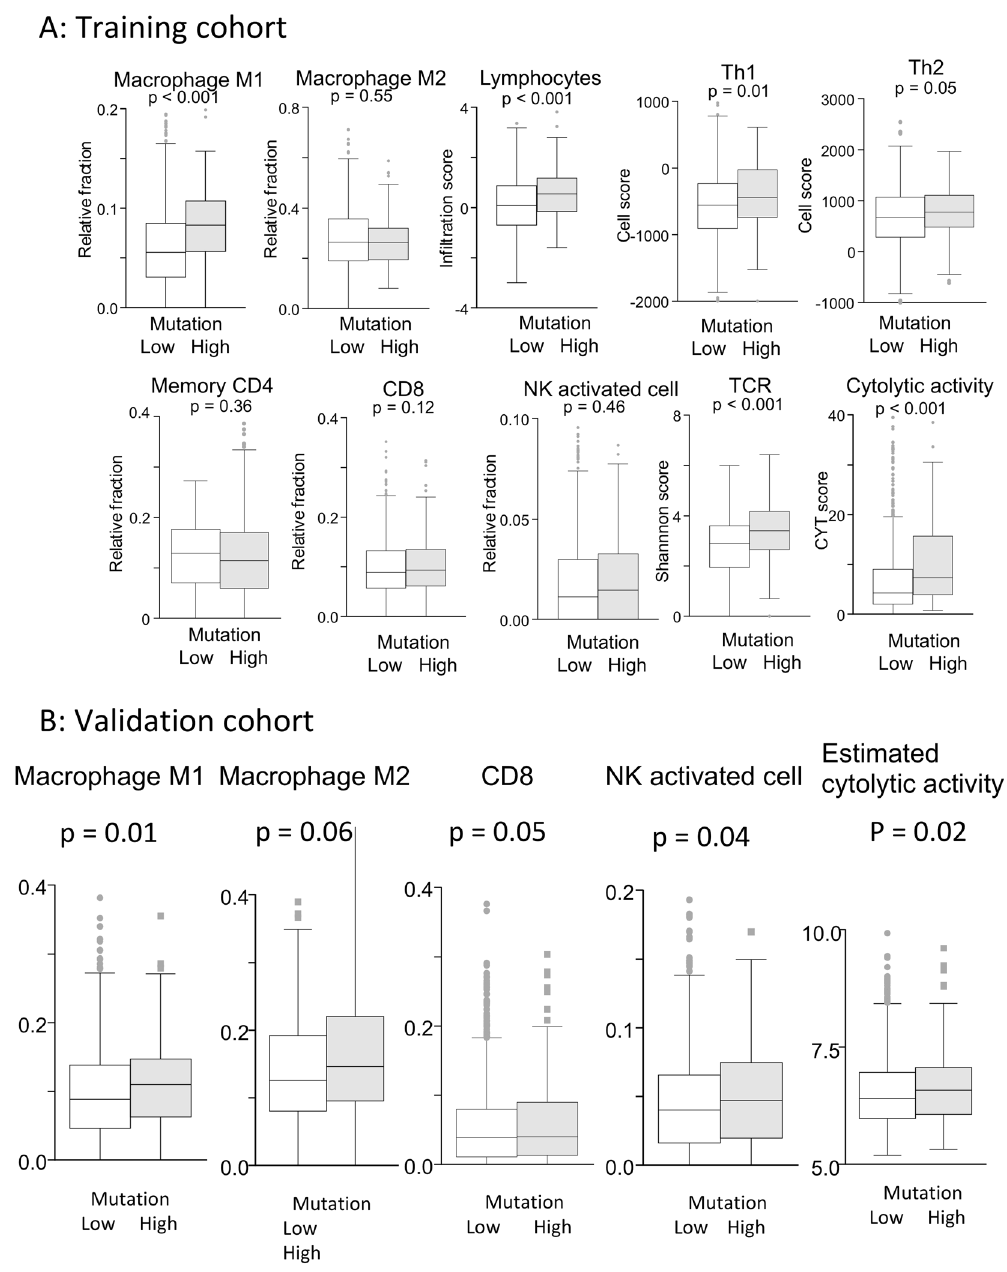
Figure 6. ( A ) In the training cohort, CIBERSORT demonstrated that high infiltration of Macrophage M1 (p < 0.001), but not M2 (p = 0.55) in tumors with high mutation rates. Similarly, infiltration score of lymphocytes (p < 0.001) was elevated, especially Th1 (p = 0.01), but not Th2 (p = 0.05) or Memory CD4 T cells (p = 0.32). Neither CD8 + T cells (p = 0.12) nor NK cells (p = 0.46) were significantly infiltrated in tumors with high mutation rates. Additionally, tumors with high mutation rates correlated with significantly more TCR diversity (p < 0.001), reflecting higher neoantigen load in tumors. With this increased TCR diversity, CYT (p < 0.001) was also significantly elevated in tumors with high mutation rates. ( B ) Similar trend was observed in the validation cohort. Tumors with high mutation rates were associated with higher infiltration of Macrophage M1 (p = 0.01), but not M2 (p = 0.06) in tumors with high mutation rates. CD8 + T cells (p = 0.05) and NK cells (p = 0.04) were significantly infiltrated in tumors with high mutation rates. Tumors with high mutation rates was associated with estimated cytolytic activity (p = 0.02). Th1, helper T lymphocytes; Th2, helper T lymphocytes; NK cells, natural killer cells; TCR, T cell receptors; CYT, cytolytic activity Several studies demonstrated that hypermutation is associated with increased TILs in TME due to neoantigens generation 5,7,13 . Innocenti and colleagues recently reported that higher tumor mutation rates correlated with bet- ter survival in patients with microsatellite stable (MSS) colorectal cancer, where mutation rates are far less com- mon than MSI-high tumor 51 . They suggested that the survival benefit was a reflection of increased neoantigens